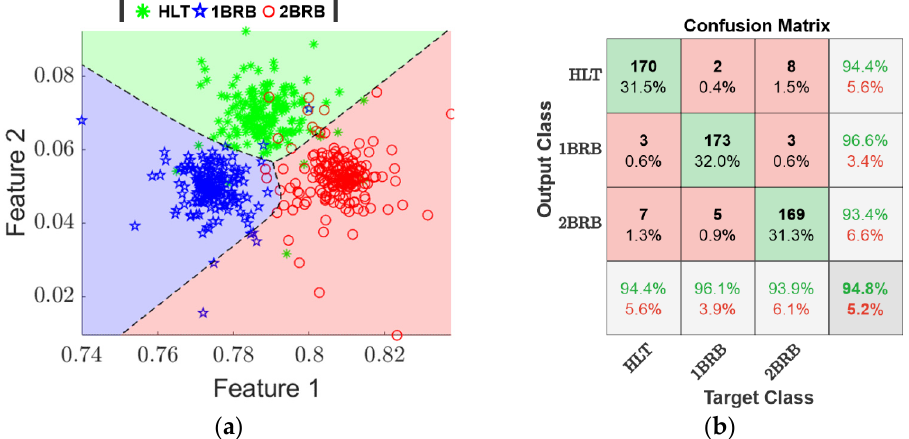
Figure 12. Classification results of the proposed methodology obtained for the Siemens soft-starter. ( a ) Resulting decision regions modelled by the proposed NN-based classifier over the 2-dimensional space; ( b ) Confusion matrix.